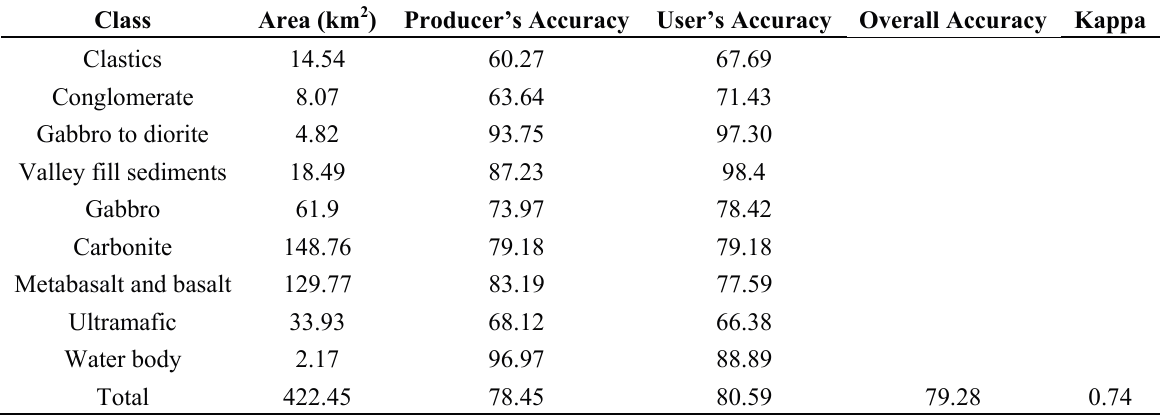
Table 3. Classification accuracy of the MOC area using SVM